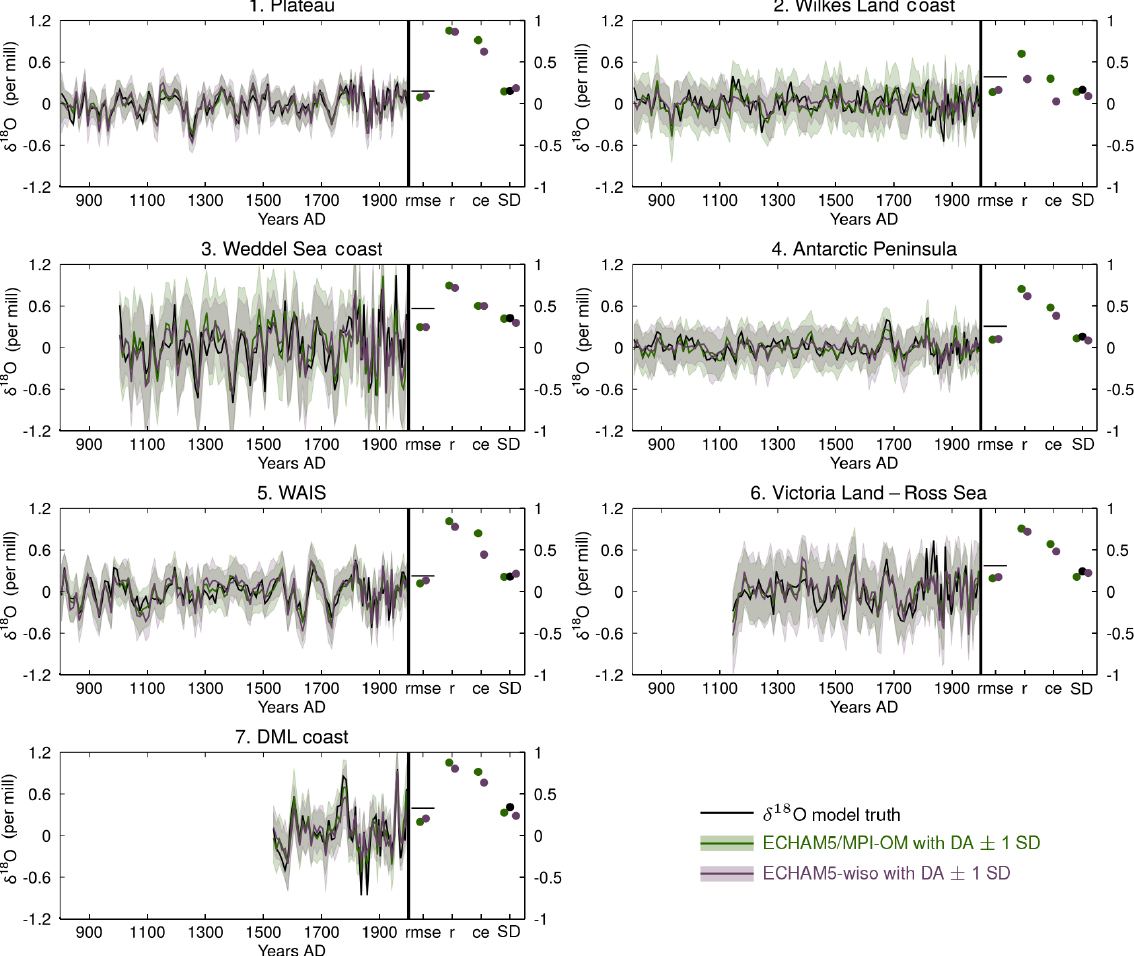
Figure 5. Changes in δ 18 O in precipitation over the 800–2000CE period in the model truth (ECHAM5/MPI-OM, from which the assimi- lated pseudoproxies are derived, in black), and in the data assimilation-based reconstructions using the ECHAM5/MPI-OM (in green) and ECHAM5-wiso (in violet) model ensembles. The results are 10-year averaged over the 800–1800CE period and 5-year averaged over the 1800–2000CE period. All series are anomalies using the whole periods as a reference. The uncertainty of the reconstructions is shown using colored shading ( ± 1 standard deviation of the model particles scaled by their weight around the mean). Diagnostics related to the skill of the reconstructions are displayed on the right of each panel: the RMSE between the reconstructions and the model target (rmse, in per mill) along with the pseudoproxy error estimates (the horizontal black lines), the correlation coefficients between the reconstructions and the model target ( r ), the coefficient of efficiency of the reconstructions (ce), and the standard deviation of the reconstructions and the model target